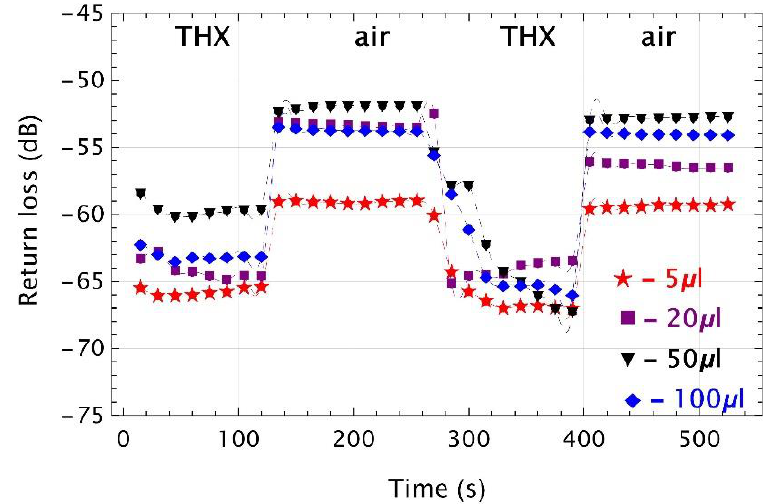
Figure 12. Time responses of UV microtips twice inserted into and removed from the vial filled with four different volumes of 1,4-thioxane (THX). Colored plot markers indicate experimental points, while the dashed lines are data interpolations.